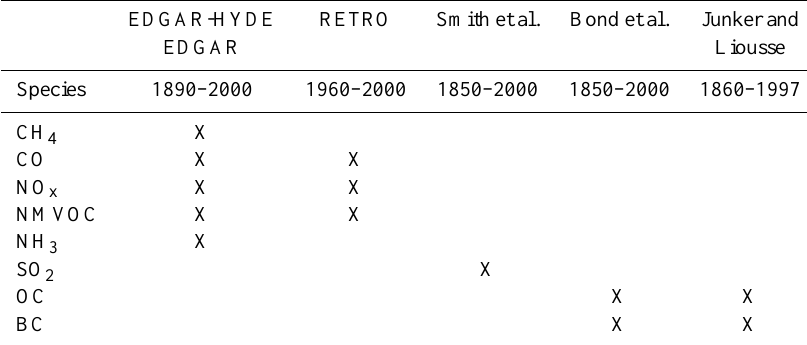
Table 1. List of multi-decadal inventories used in this study.